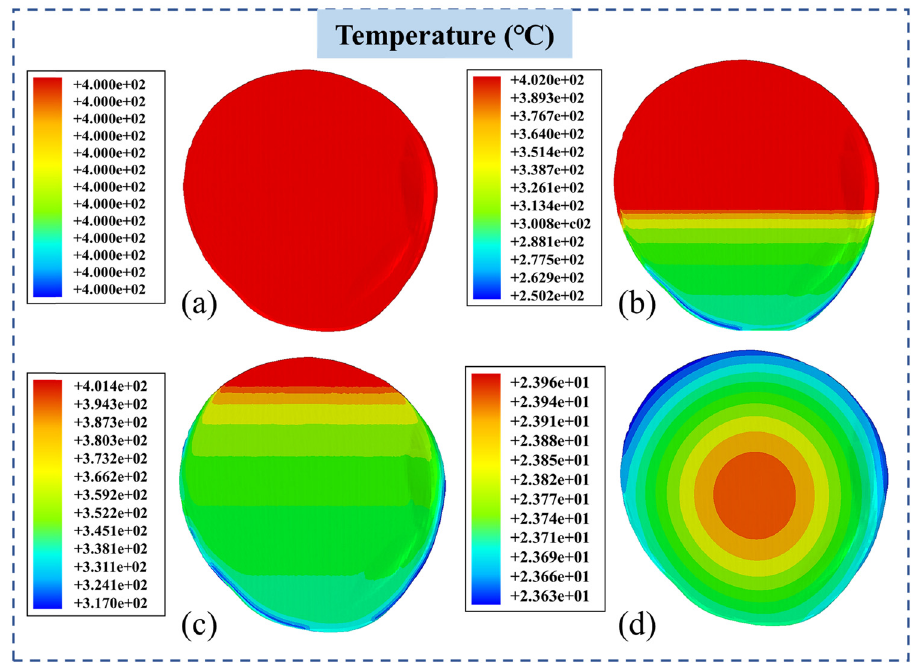
Figure 6: Changes in temperature fi eld during quenching cooling: ( a ) before cooling, ( b ) and ( c ) during cooling, and ( d ) after